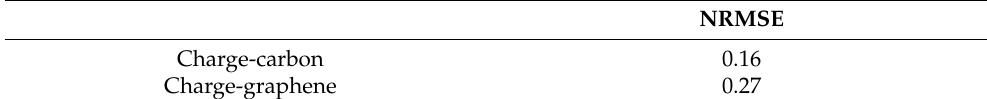
Figure 8. Curves of current versus time for the charge tests with different coating. Table 5. NRMSE between the curve of temperature for the uncoated and coated battery during charge mode.